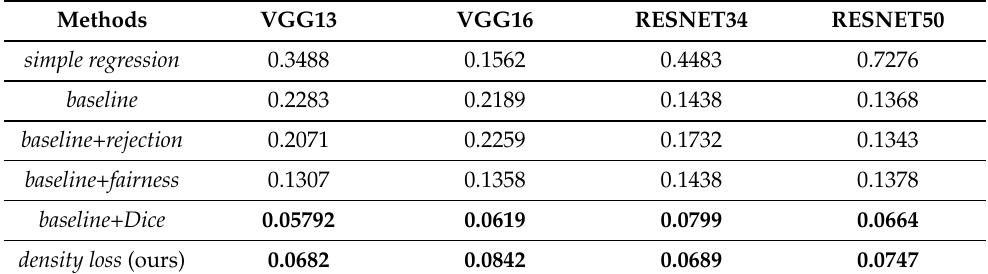
Table 3. Average distance (see Section 3.1) between true and predicted class distribution for different methods and backbones on EUROSAT . The two best results are in